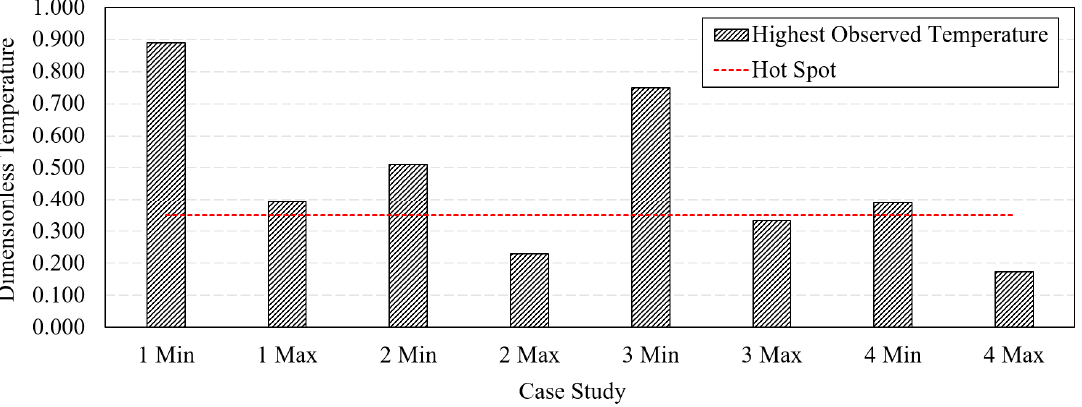
Figure 28. The maximum dimensionless temperature predicted in each case study for the maximum level and minimum level of air flow velocity.